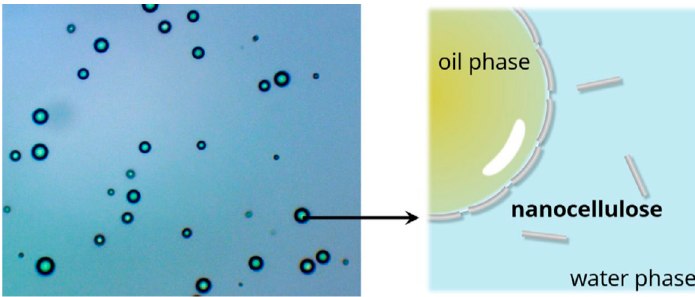
Figure 7. Scanning electron micrographs of Pickering emulsion stabilized by BCNCs. Reprinted with permission from Ref. [112]. Copyright 2017 Forestry and Forest Products Research Institute.